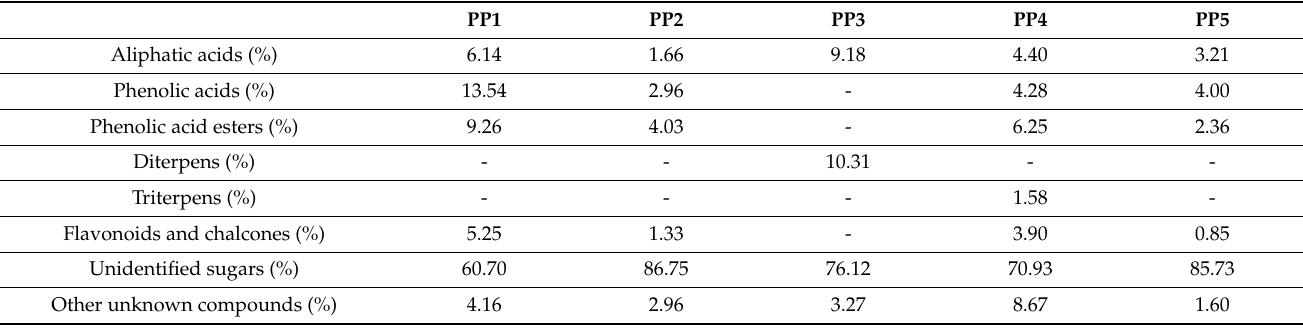
Table 2. Categories of chemical compounds of the propolis from the PNP (NW